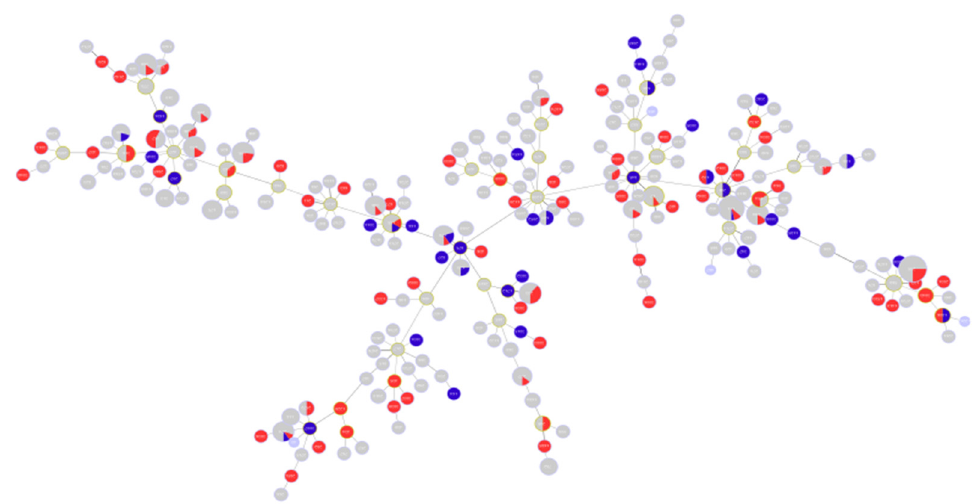
Figure 5. MST diagram showing distribution of ciprofloxacin susceptibility in relation to different STs. Red color: ciprofloxacin-resistant ( n = 105); blue color: ciprofloxacin-susceptible ( n = 37); grey color: unknown susceptibility to ciprofloxacin.